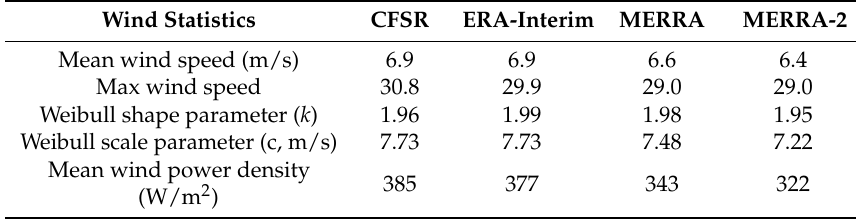
Table 3. Wind statistics of hourly reanalysis data at HeMOSU-1 location (100 m above sea level).